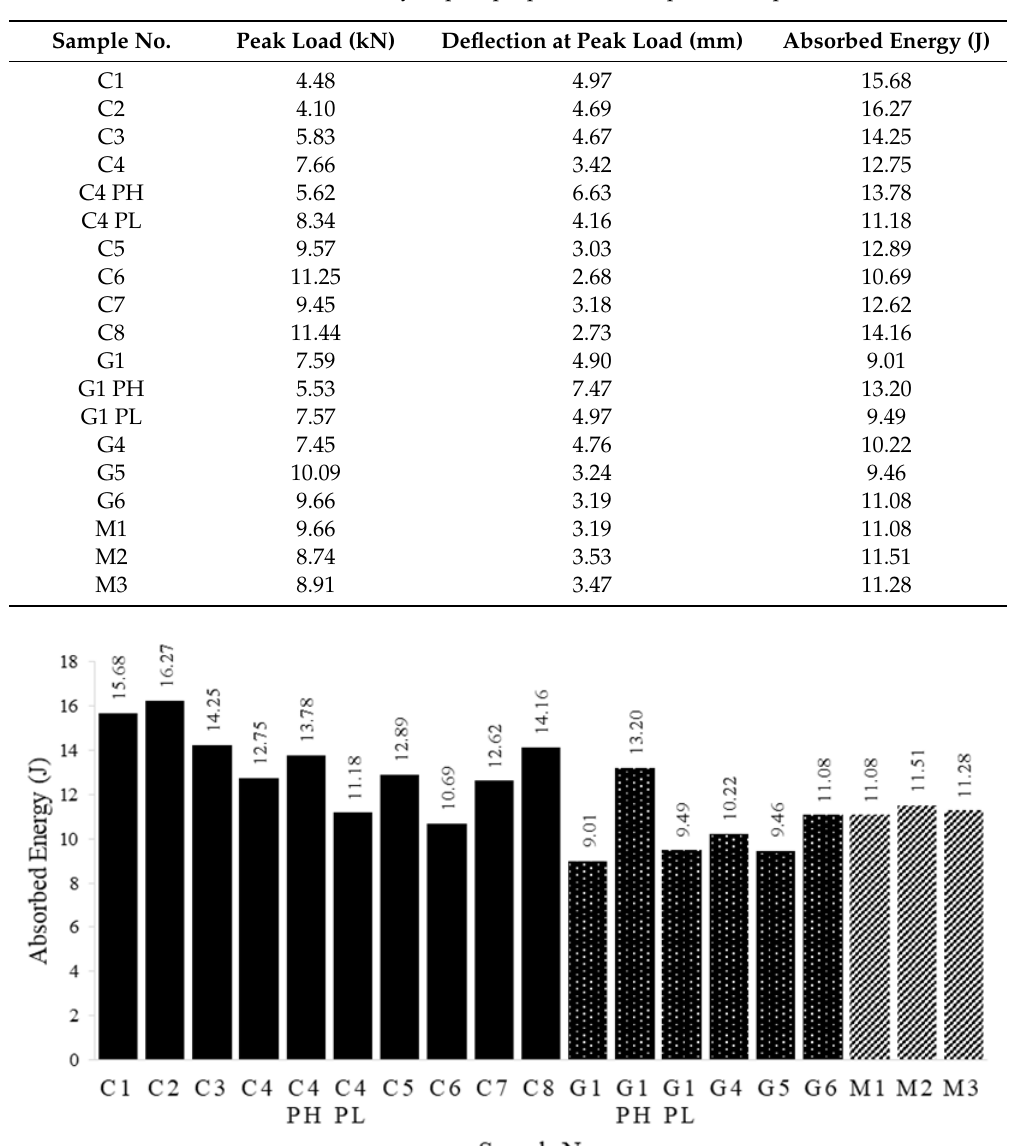
Table 2. Low-velocity impact properties of composite samples.